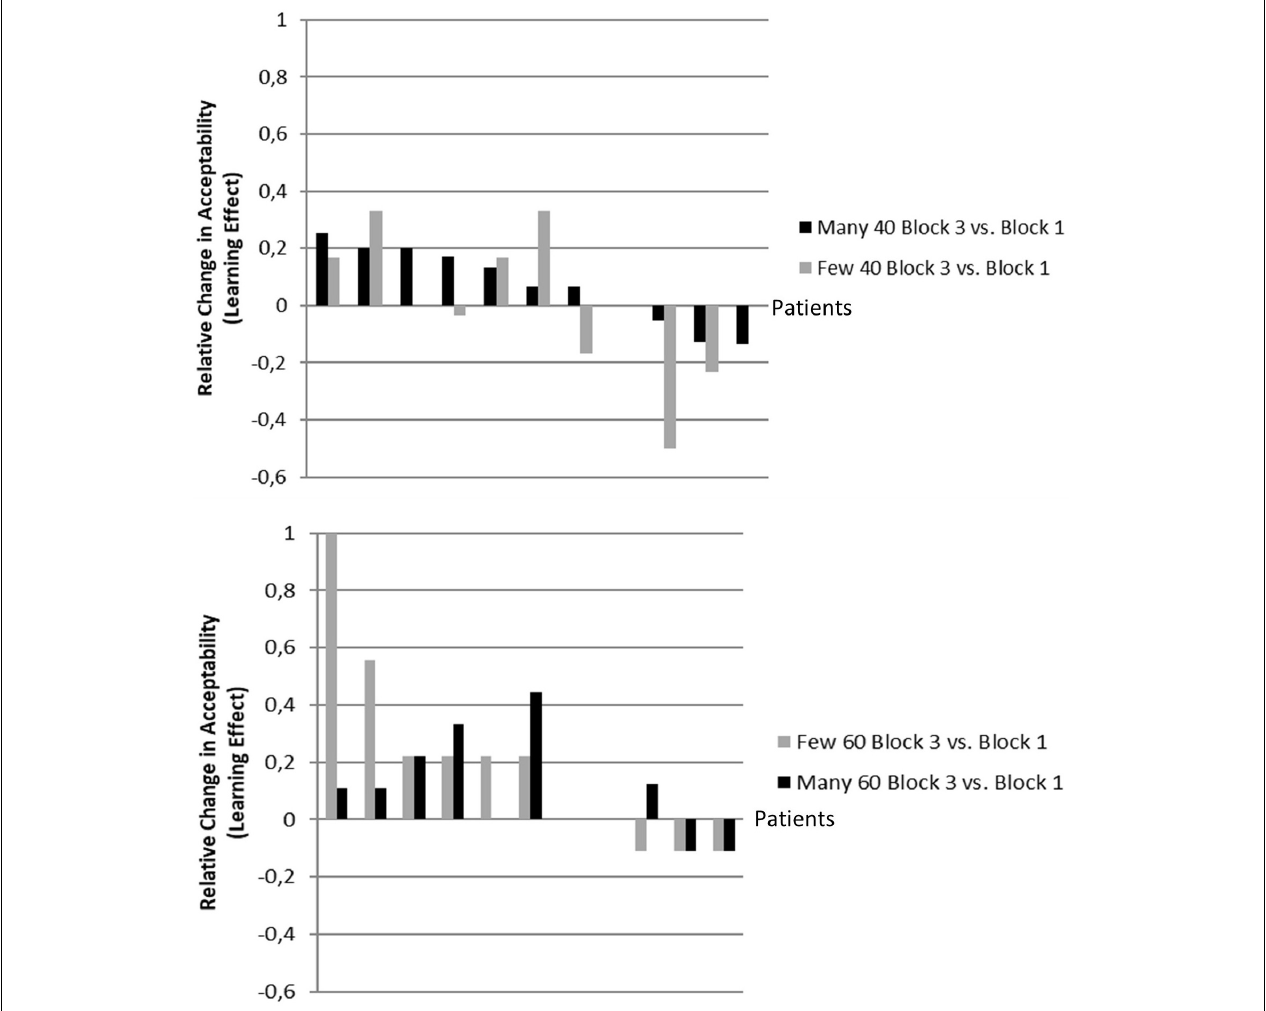
FIGURE 4 | Individual learning for the trained (direct) and untrained (transfer) quantifier in Experiment 1 (above) and Experiment 2 (below) , sorted by the size of the direct reinforcement learning effect (above: black bars; below: gray bars). Each pair of bars represents one patient. If no change was found for a patient, i.e., in case the difference is zero, this patient’s bar/s is/are not appearing in the graph accordingly but leaves a